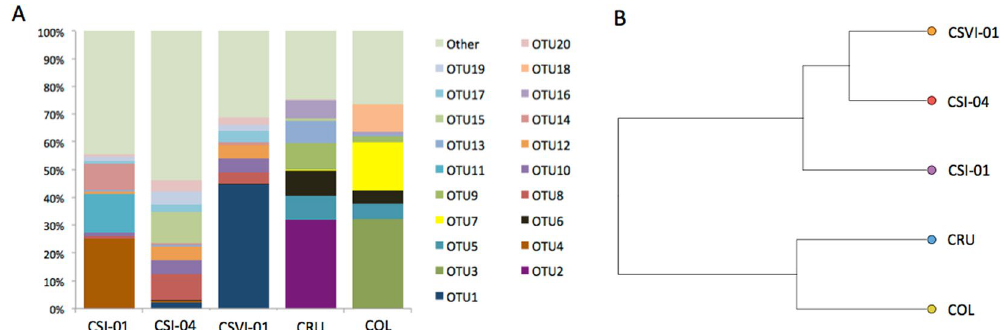
Figure 3. Taxonomic profiles of rock-art microbial communities obtained through 16S rRNA metagenomic sequencing. ( A ) Relative abundance of the 20 most abundant species-level OTUs detected in the analysis. OTUs are numbered in accordance with Table 2. ( B ) UPGMA clustering of the samples in accordance with their global taxonomic profile.